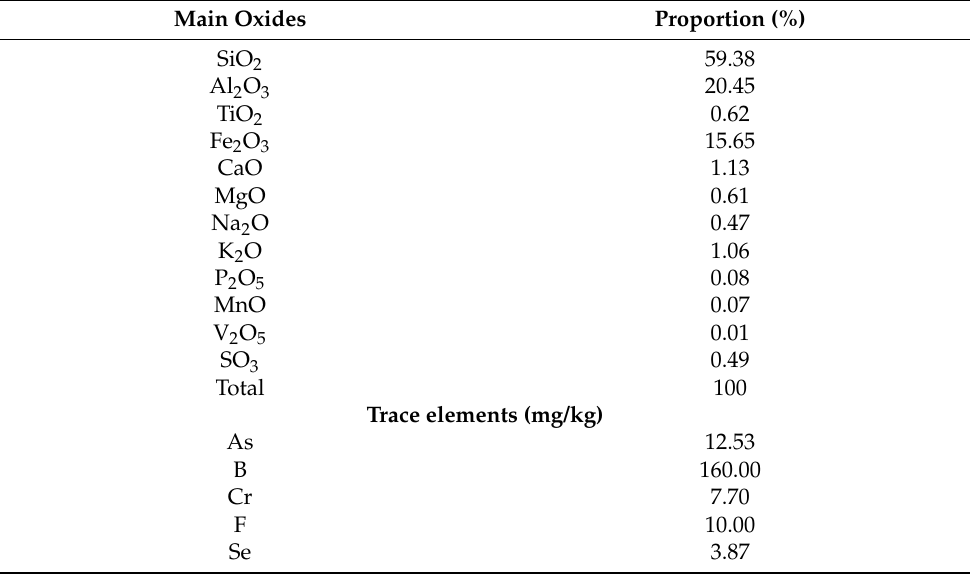
Table 2. Chemical composition of